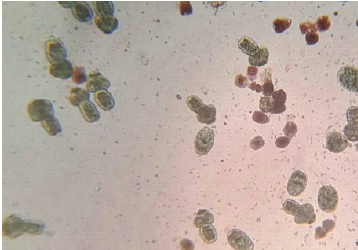
Fig. 8. Effect of the alcoholic extract of the Spirogyra sp .